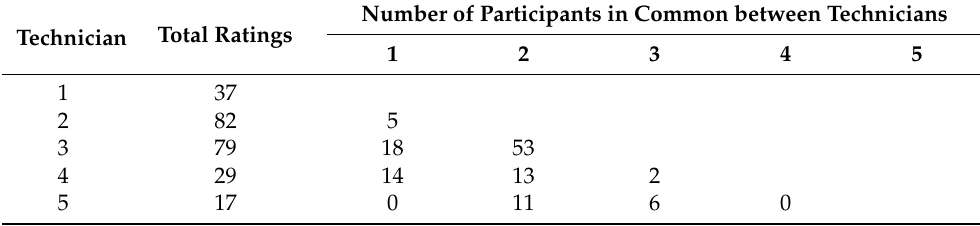
Table 2. Number of participants for which each of five trained technicians manually computed relative fundamental frequency 1